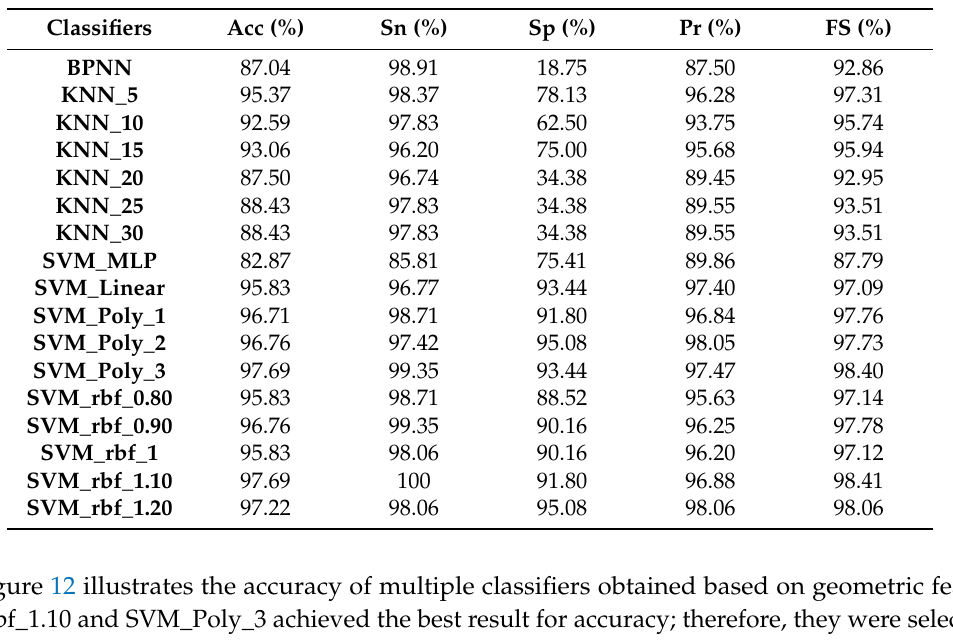
Table 5. Performance of multiple classifiers using geometrical features (Acc: accuracy, Sn: sensitivity, Sp: specificity, Pr: precision, and FS: F-score).